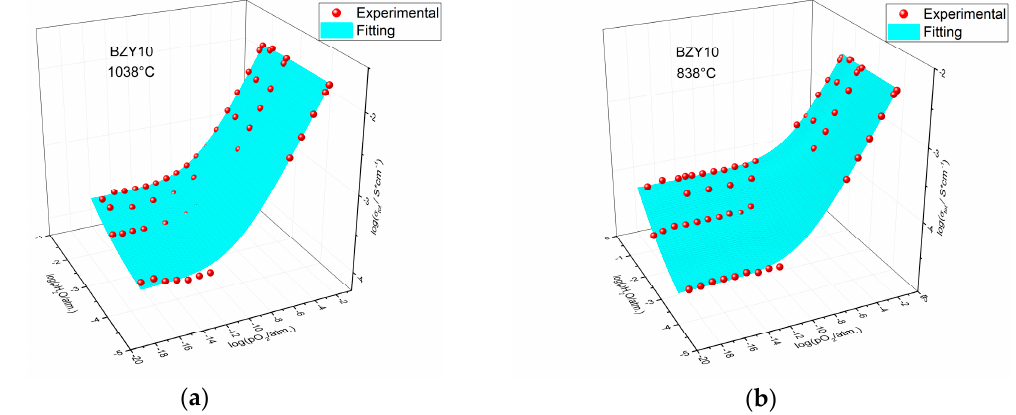
Figure 3. The results of fitting for BZY10 total conductivity at ( a ) 1038 °C and ( b ) 838 °C. Points-experimental data, surface-results of calculation according to Equation (4) with fitted parameters given in Table 1.